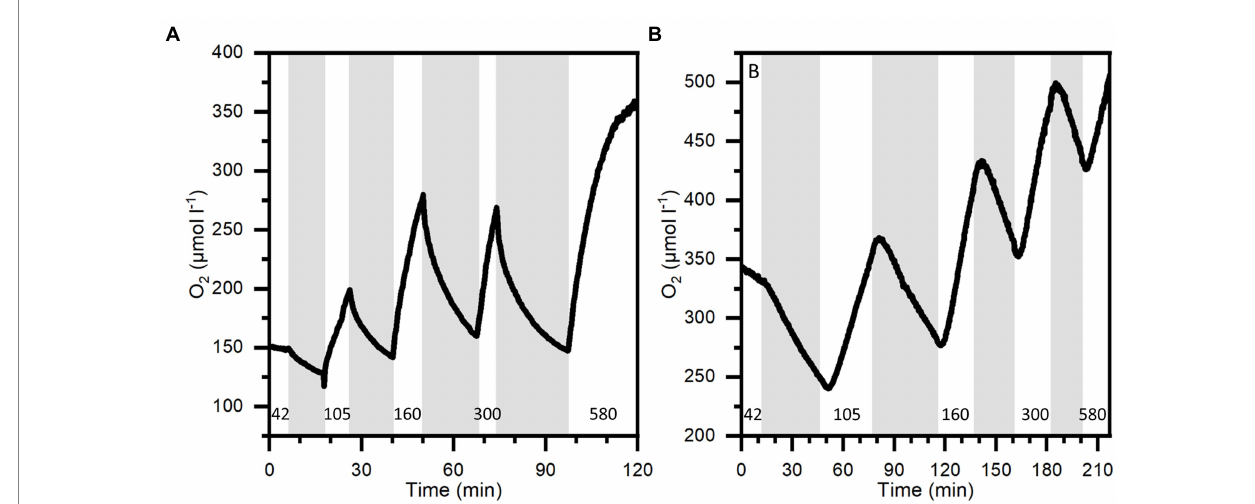
FIGURE 6 O 2 dynamics at 1 mm depth into the bell of a small medusa (A) and 3 mm into the bell of a large medusa (B) during light–dark shifts. Gray areas indicate dark shifts and white areas indicate photo periods of increasing incident photon irradiance (400–700 nm) noted with numbers in units of μ mol photons m − 2 s − 1 . Note differences in x - and y -axes.